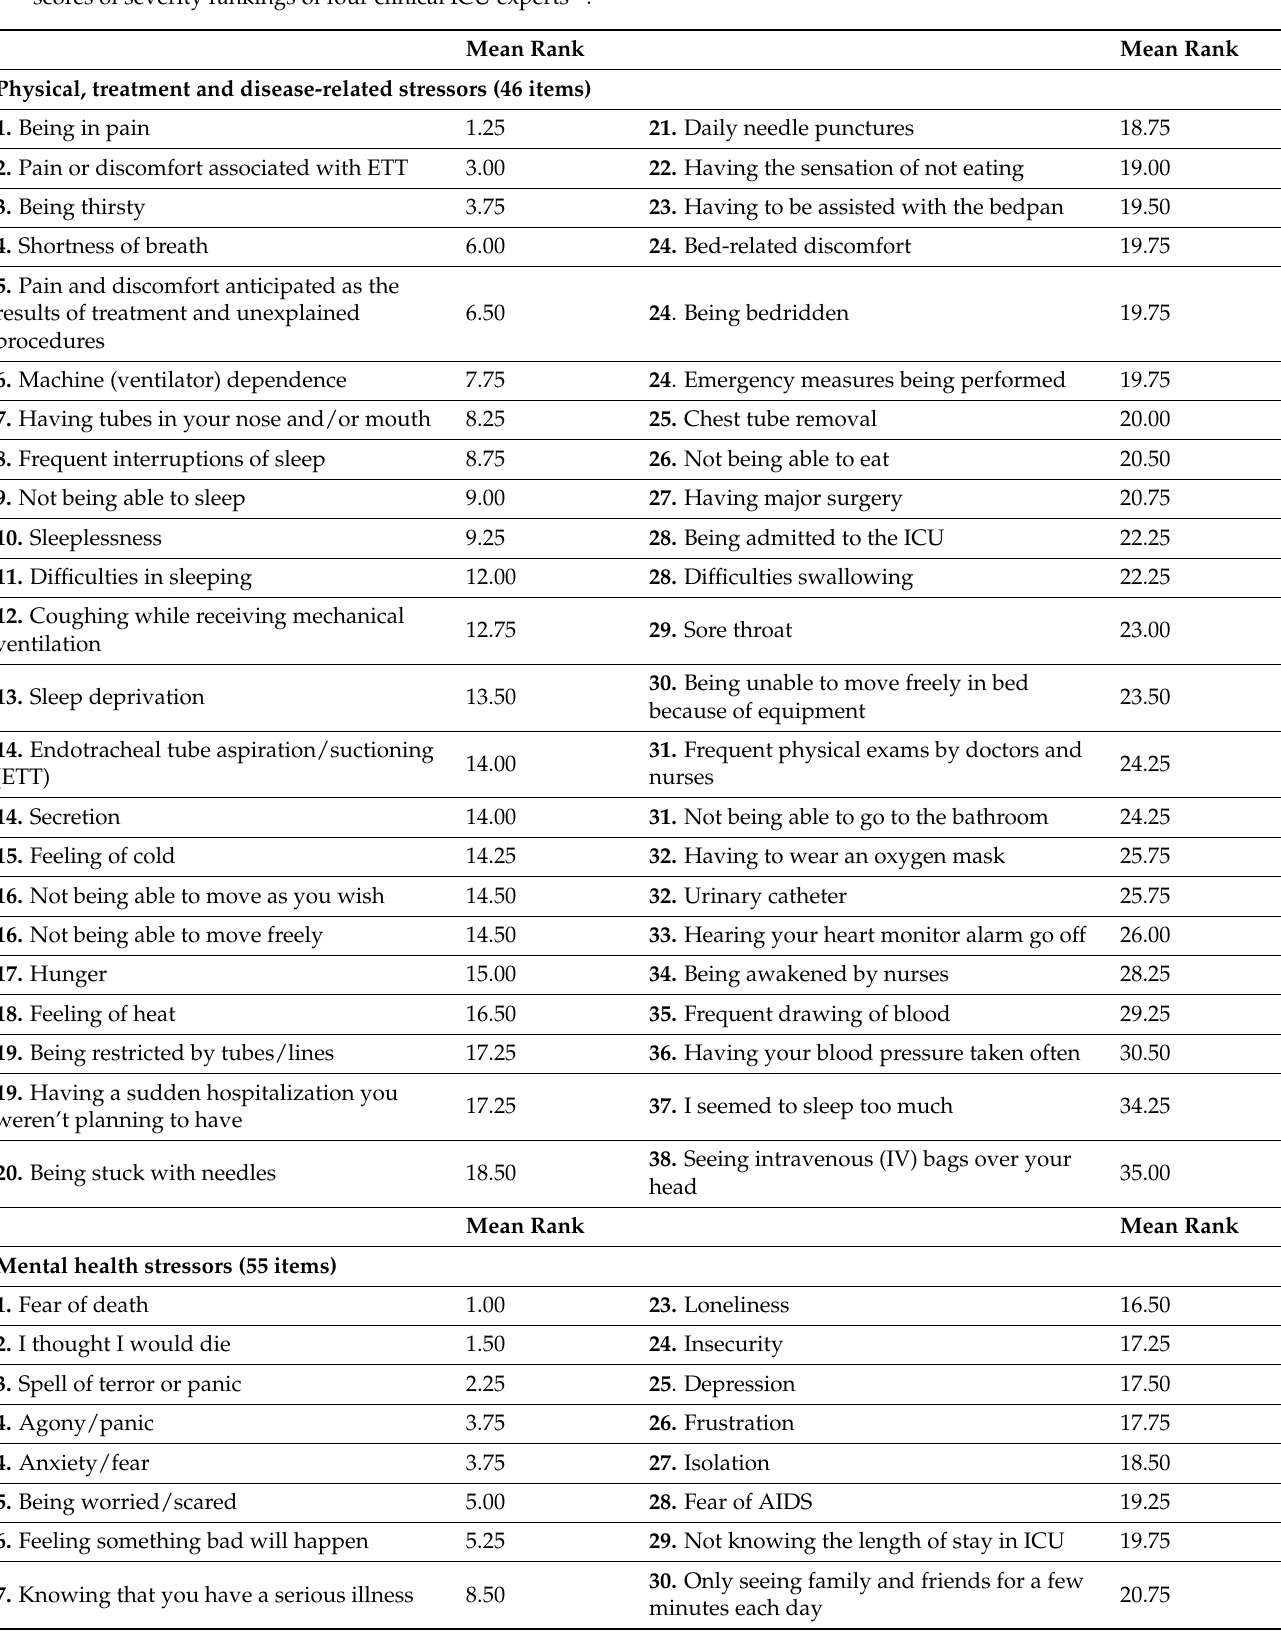
Table 2. Synthesis of perceived severity of stressors in the ICU: Ranking lists of four stressor domains according to mean scores of severity rankings of four clinical ICU experts +